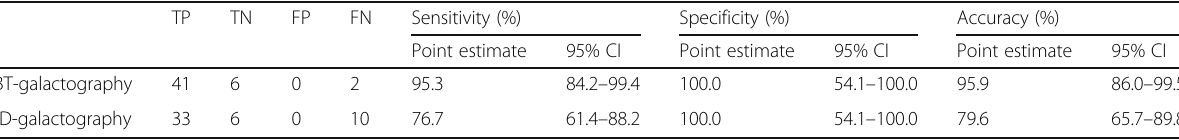
Table 1 Diagnostic performance of digital breast tomosynthesis (DBT)-galactography and full-field digital (FFD)- galactography in 49 patients with pathologic nipple discharge TP DBT-galactography